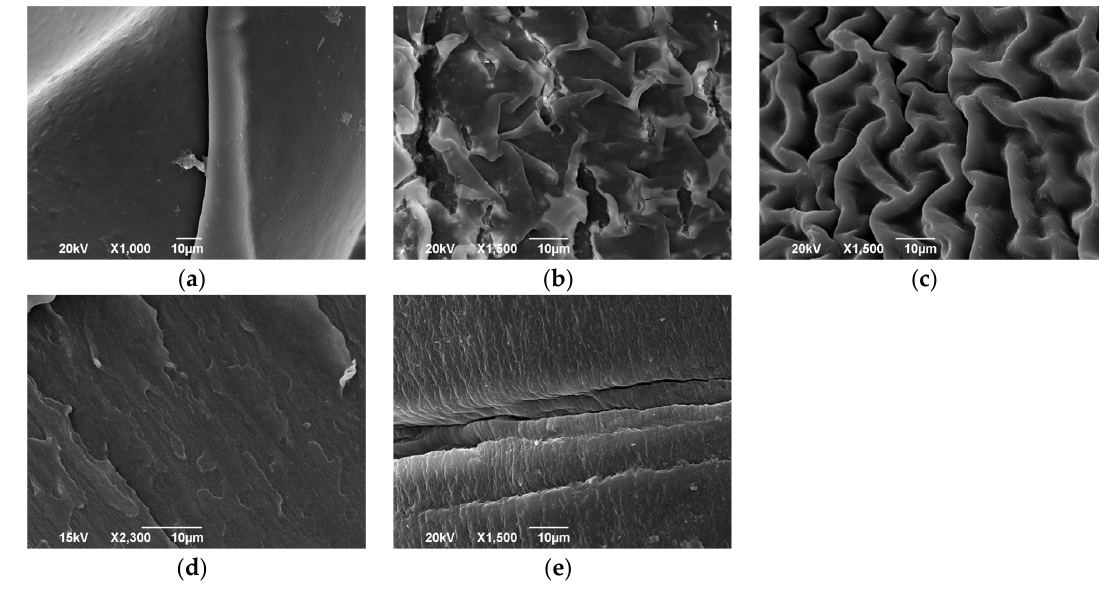
Figure 6. SEM images of: ( a ) PNBE homopolymer; ( b ) PNBE/PNBD 400/100 copolymer; ( c ) PNBE/PNBD 700/700 copolymer; ( d ) PNBE/PNBD 100/400 copolymer; ( e ) PNBD